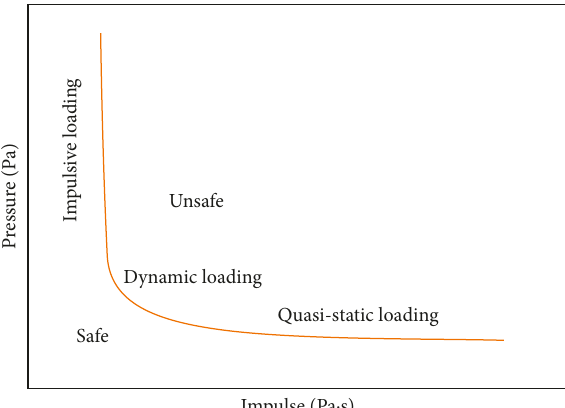
Figure 3: Typical PI diagram: impulsive, dynamic, and quasi-static loading (logarithmic scale).